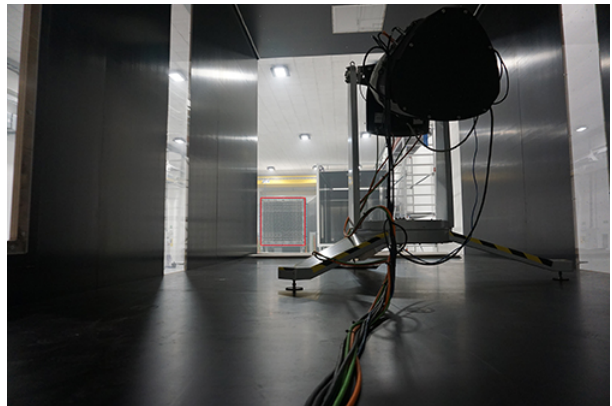
Figure 2. View into the wind tunnel from the perspective of Wind- Scanner 1.